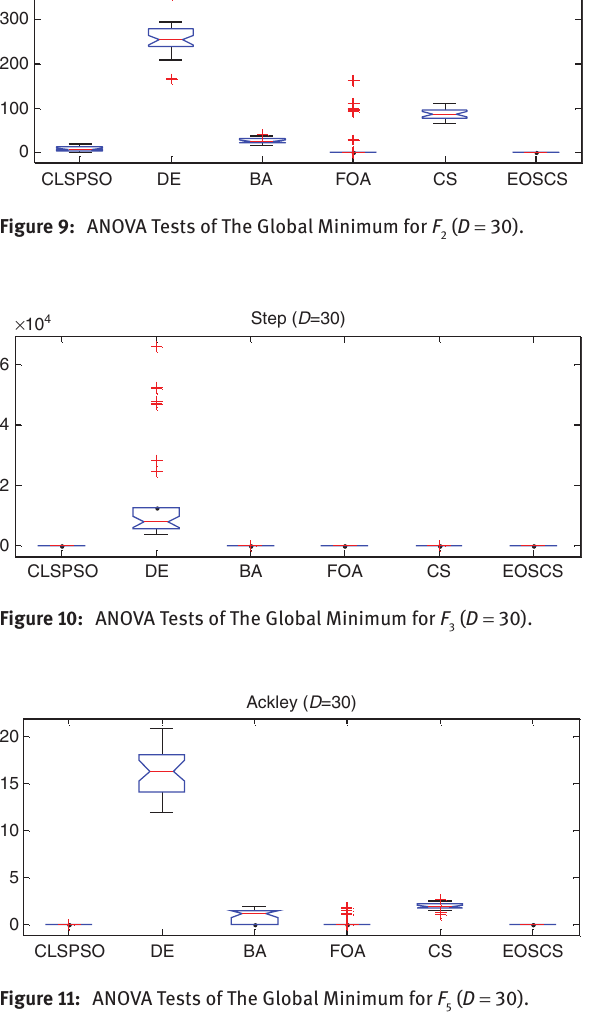
Figure 11: ANOVA Tests of The Global Minimum for F